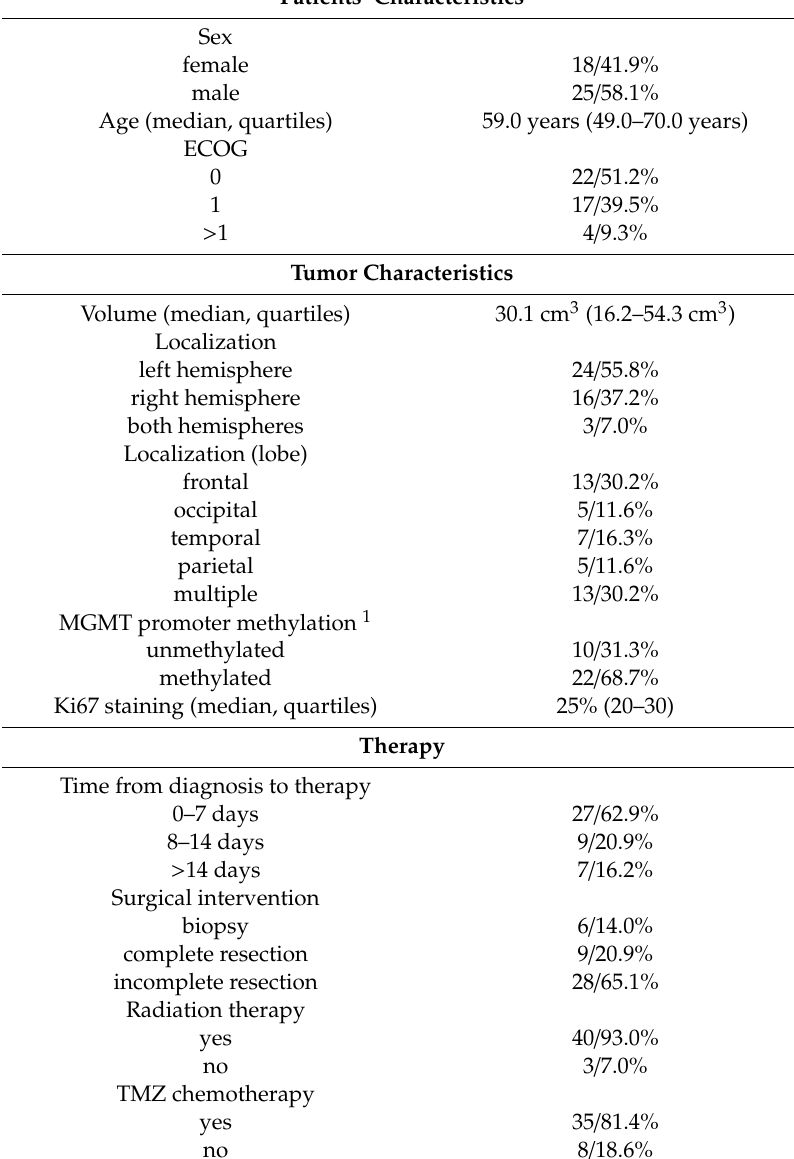
Table 2. Clinical parameters of glioblastoma multiforme (GBM) patients ( n =